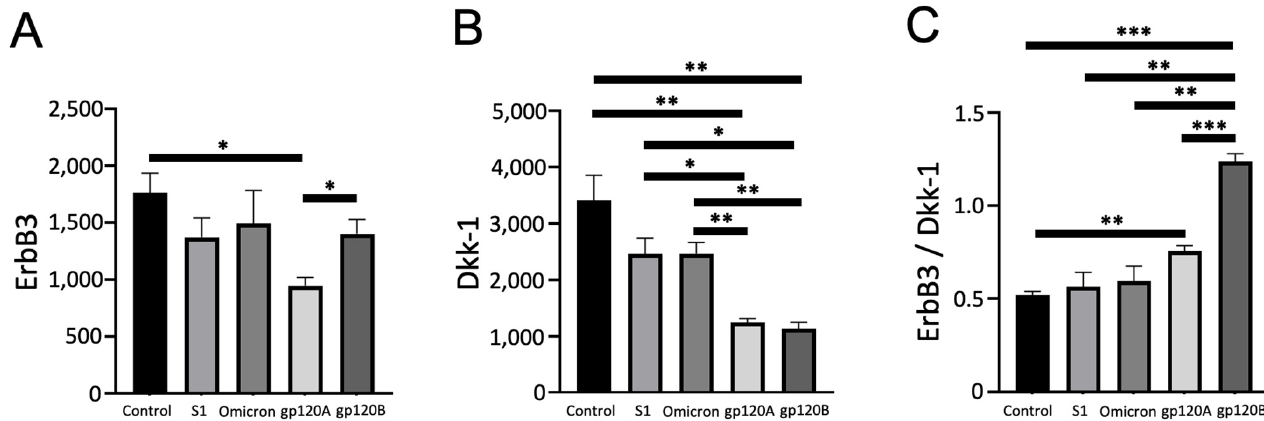
Figure 5. Characteristic of the effects gp120 proteins of HIV-1 Group M Subtype A and Subtype B on the ErbB3 expression. Human pulmonary artery endothelial cells were treated with SARS-CoV-2 spike proteins S1, Omicron S1, and gp120 of HIV-1 Subtype A (gp120A) or Subtype B (gp120B) at 1 nM for 20 h in triplicate. Expression patterns of various proteins were monitored using R&D Human XL Oncology Array. Bar graphs represent means ± SEM (N = 3 for all groups) of ( A ) ErbB3 expression, ( B ) Dkk-1 expression, and ( C ) the ratio of ErbB3 to Dkk-1 expression. * p < 0.05. ** p < 0.01. *** p < 0.001. The y -axis indicates the mean pixel density of protein